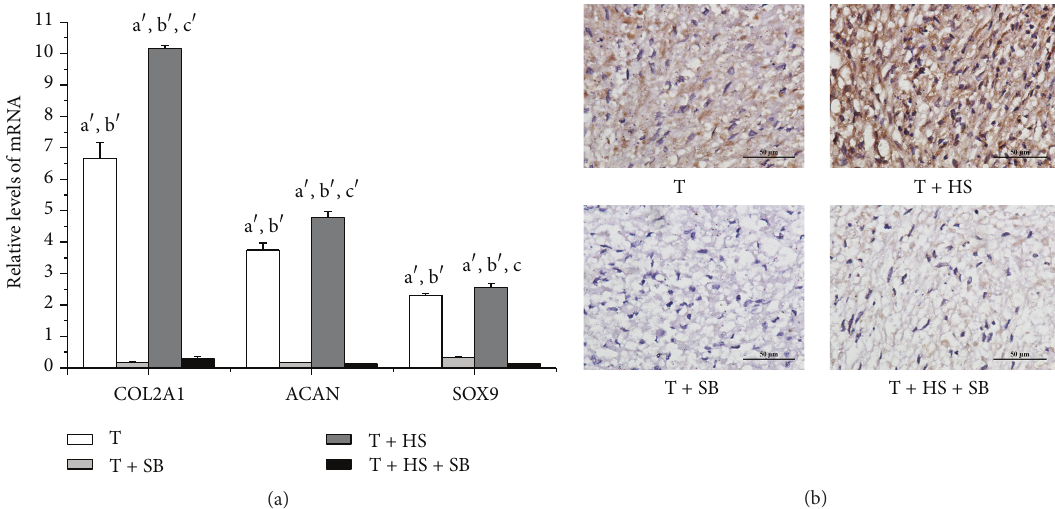
Figure 5: SB431542 inhibits HS-enhanced TGF- 𝛽 3-induced chondrogenic differentiation of hMSCs. Cells were cultured in four different media (T, T + HS, T + HS, and T + HS + SB) for 7 days. (a) mRNA levels of SOX9, ACAN, and COL2A1 are measured by real-time PCR. 󸀠 𝑃 < 0.01 󸀠 𝑃 < 0.01 versus T + SB group, b versus T + HS + SB group, c 𝑃 < 0.05 versus T group, Error bars represent the means ± SD, 𝑛 = 4 . a 󸀠 𝑃 < 0.01 versus T group. (b) Immunohistochemistry staining for collagen type II. 𝑛 = 3 , scale bar = 50 𝜇 and c